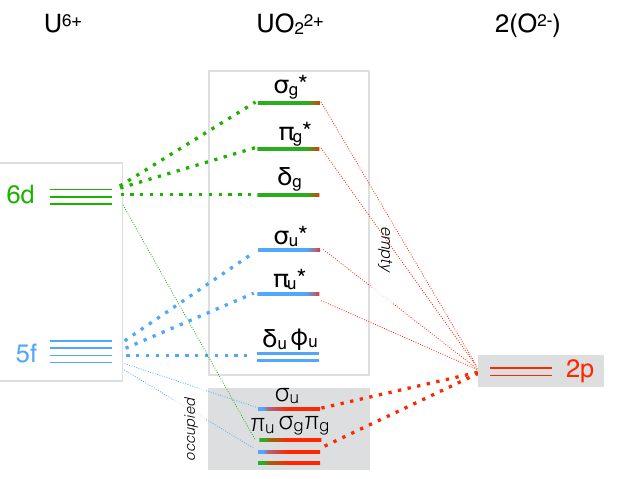
Figure 5. Proposed molecular orbital diagram of the uranyl species adapted from Reference